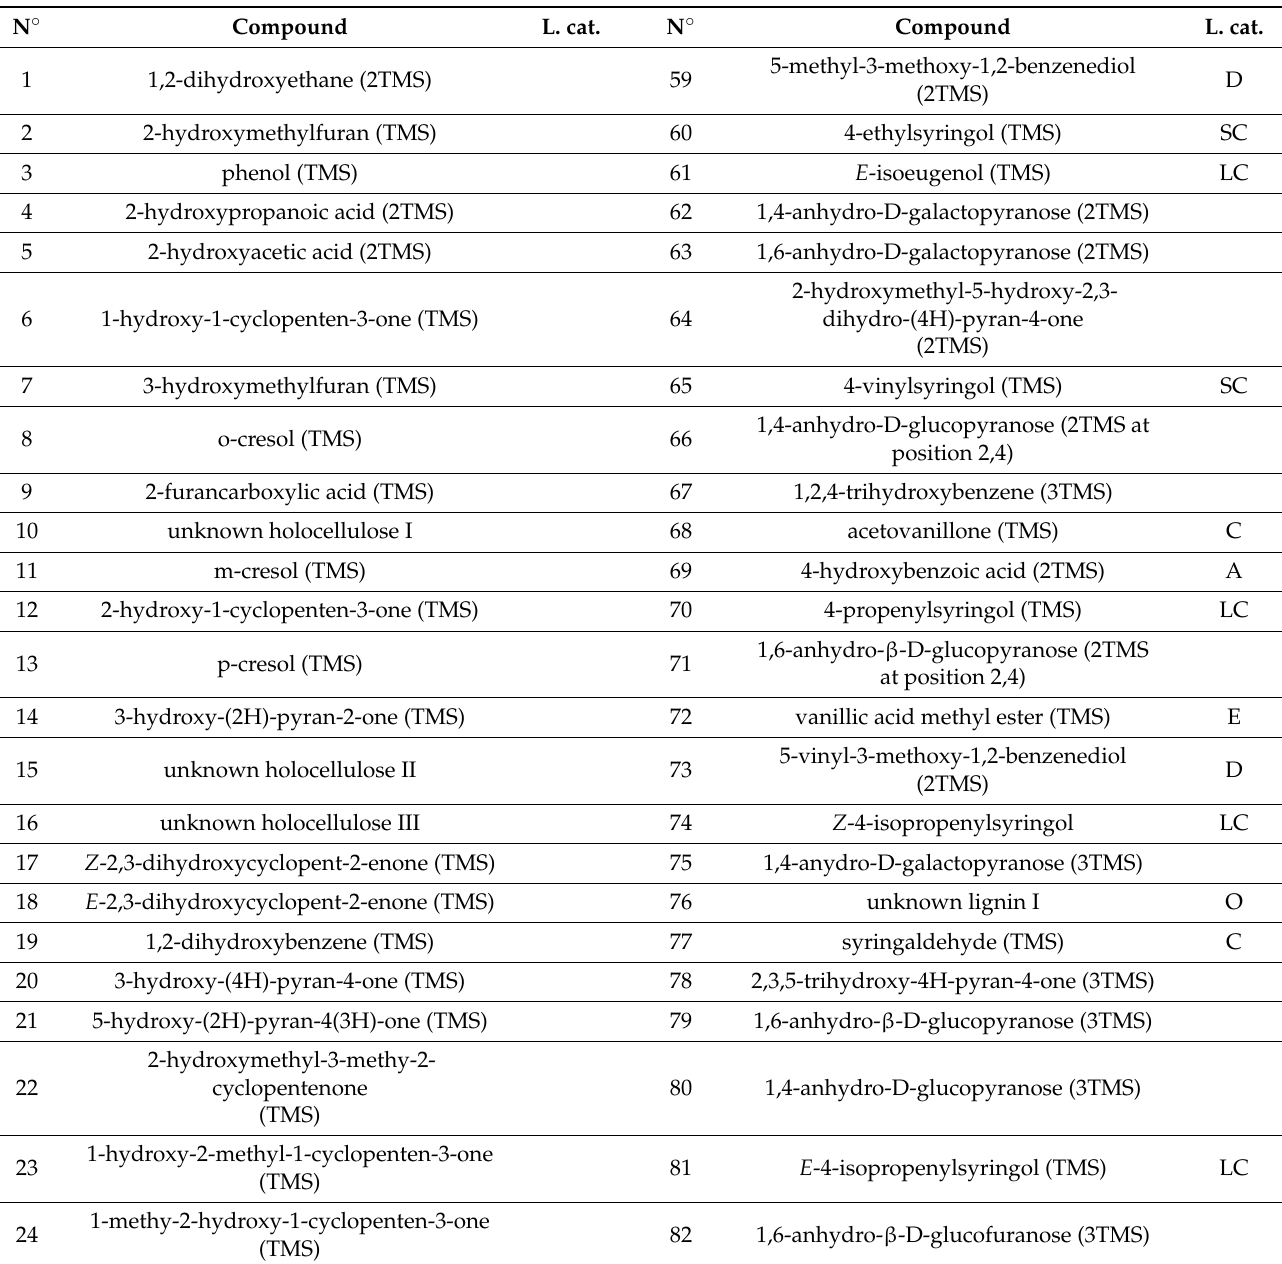
Table 3. List of wood pyrolysis products identified by Py(HMDS)-GC/MS. In the case of lignin pyrolysis products, lignin categories (L. cat.) are indicated: SC—short chain; LC—long chain; M—monomers; C—carbonyl; A—acids; D— demethylated/demethoxylated; E—esters; and O—others. The other pyrolysis products mainly derive from